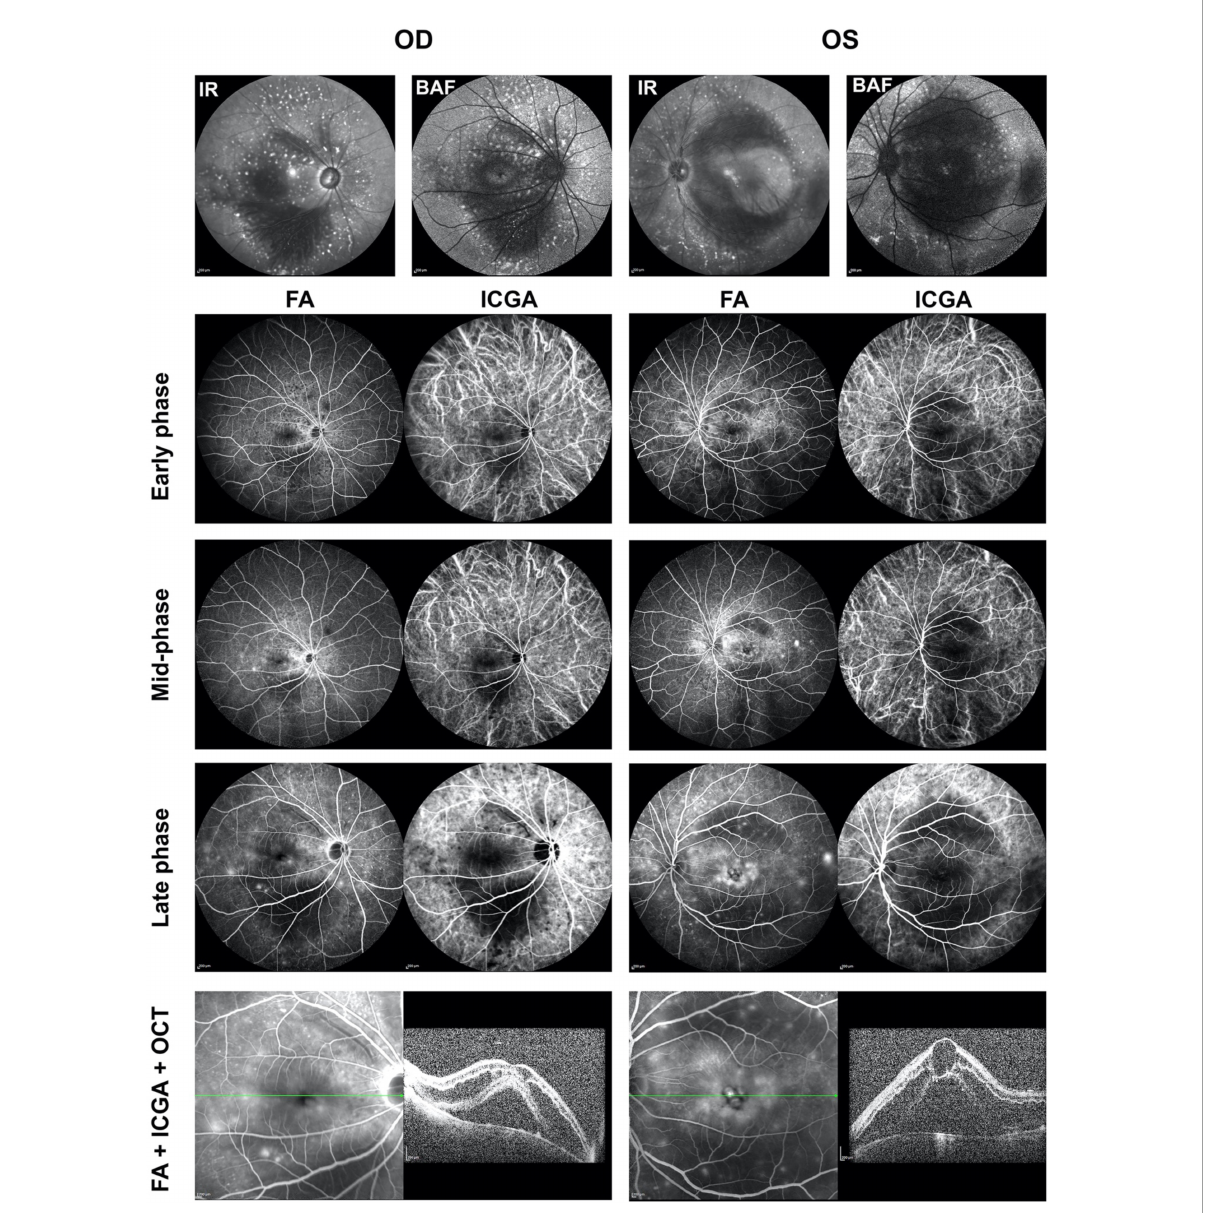
FIGURE4 Fluorescein angiography (FA) and indocyanine green angiography (ICGA) showed bilateral changes of retinal and choroidal vessels. Infrared (IR) image showed patched hypo-reflection in macula and hyper-reflective flecks surrounding the macula and optic discs in both eyes. Background autofluorescence (BAF) image showed patched hypo-autofluorescence in macula and hyper-autofluorescence flecks surrounding the macula and optic discs in both eyes. Both FA and ICGA showed delayed and slow perfusion of the retinal and choroidal vessels. The flecks were early blocking with late staining. FA showed macular leakage with pronounced cystoid macular edema, deep masking in the area of the choroidal detachment. ICGA showed dilation and congestion of the choroidal vessels, especially vortex veins, in both eyes. SD-OCT with the Heidelberg Spectralis showed cystoid macular edema with intraretinal fluid and subretinal fluid accumulation in both eyes. FA, fluorescein angiography; ICGA, indocyanine green angiography; IR, infrared; BAF, background autofluorescence; OD, right eye; OS, left